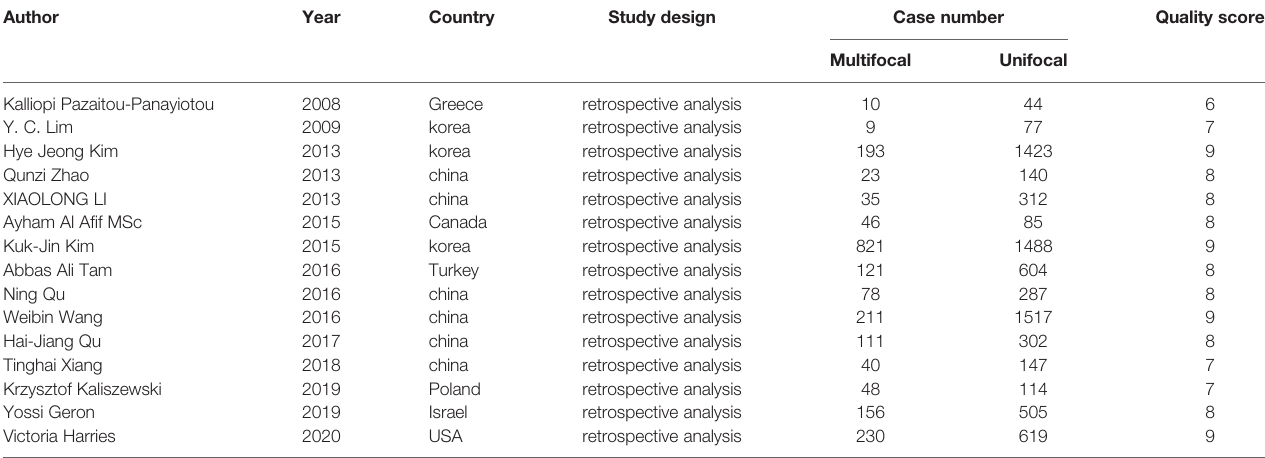
TABLE 1 | Characteristics of eligible